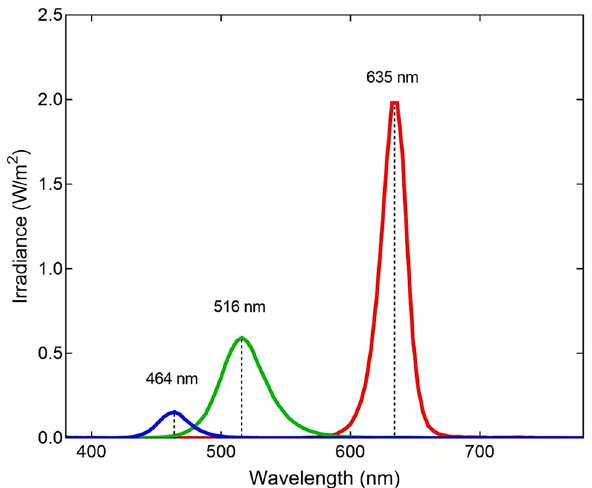
Figure 4. Spectral irradiance (W/m 2 ) of the three monochromatic lights used in this study. Irradiance peaks are 464 nm (blue), 516 nm (green) and 635 nm